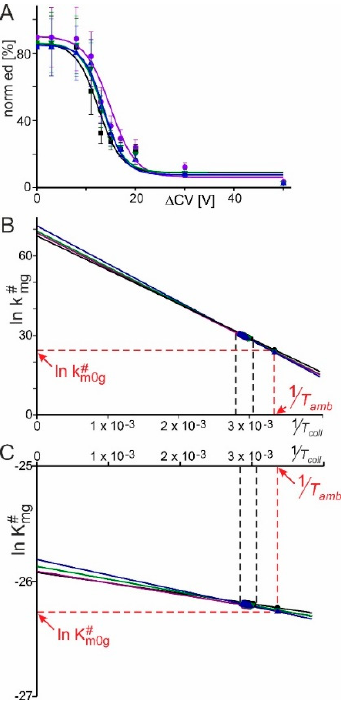
Figure 4. (A ): Courses of normalized ion intensities of RNAse S ions ( nor m ( ed ) ) as functions of collision cell voltage differences ( ∆ CV ). Black lines and data points: 10% methanol; violet lines and data points: 20% methanol; dark green lines and data points: 30% methanol; dark blue lines and data points: 40% methanol. Each data point is the mean of up to three independent measurements. Vertical bars give standard deviations. Curves were fitted using Boltzmann functions. Curve parameters used for calculations are listed in Table 1. ( B ): Arrhenius plots for the courses of RNAse S dissociation in the gas phase upon spraying solutions with increasing methanol content. Values for ln k # m0g are taken from the points of the lines at 1 . Line color code as in A. ( C ): Plots for the courses of T a m b RNAse S dissociation reactions in the gas phase over temperature. Line color code as in A. Each data point (thickened parts of the lines) is obtained from Equation (4) and the values for ln K # D m0g are taken from the points of the lines at 1 . The thickened parts of the lines in B and C depict the T a m b data points from the experimentally accessible ranges (black dashed lines). Calculated kinetic and thermodynamic values are listed in Table